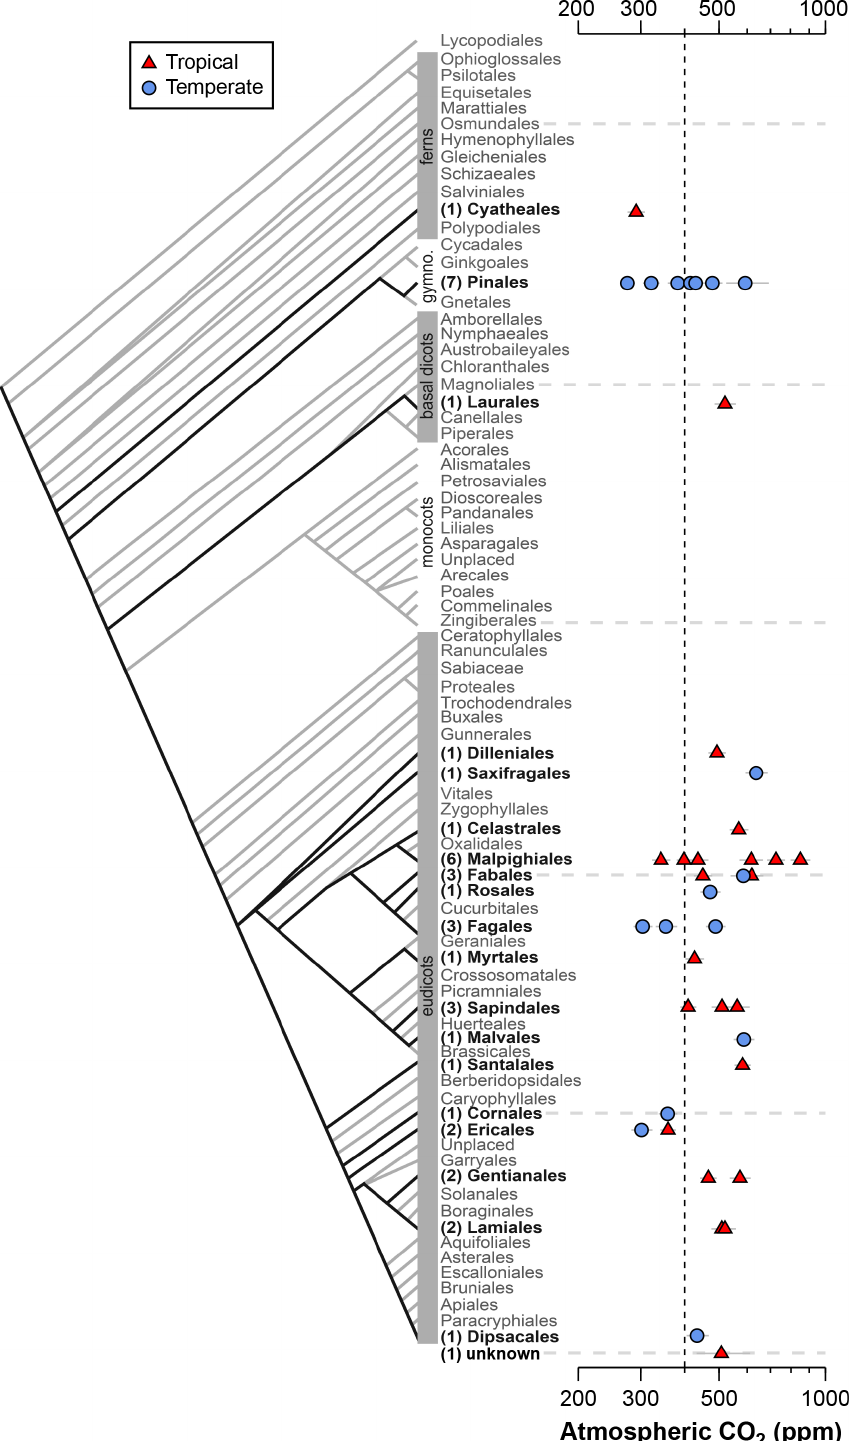
Figure 2. Estimates of CO 2 based on canopy leaves from 40 tree species. Uncertainties in the estimates correspond to the 16th–84th percentile range. Vertical line is the correct concentration (400ppm). On the left is an order-level vascular plant phylogeny (APW v.13; Stevens, 2001, onwards). The number of measured species is given in